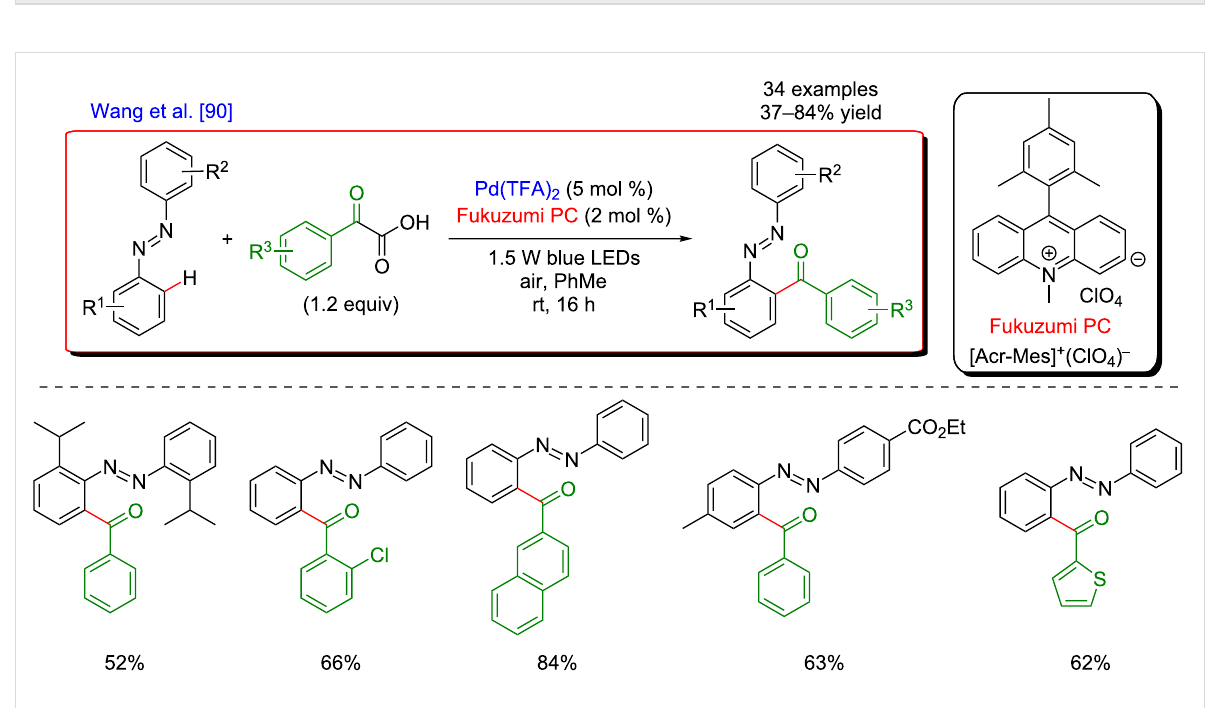
Figure 28: Proposed mechanism for the C–H acylation with α -ketoacids via dual catalysis.